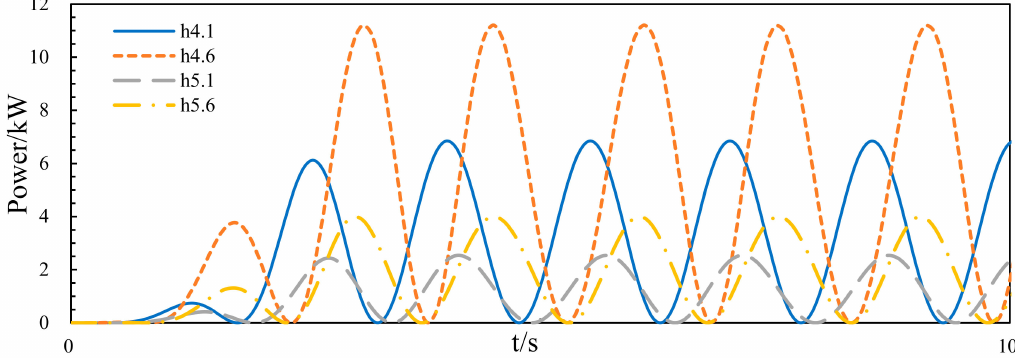
Figure 21. The instantaneous power curves of Buoy 1.